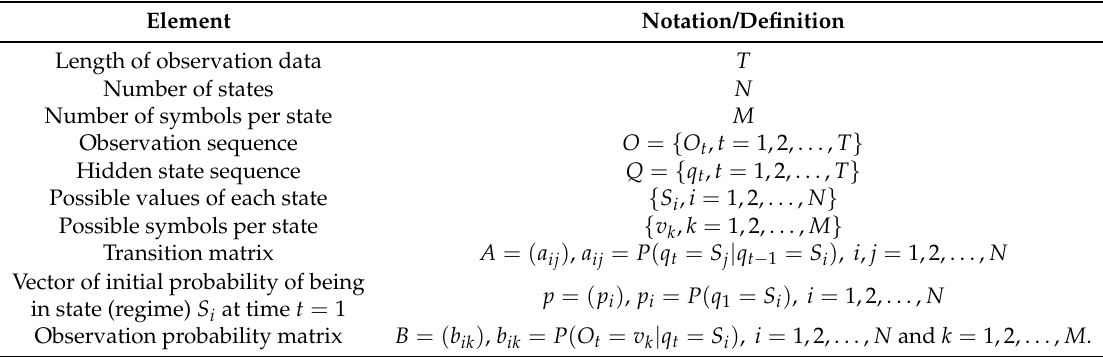
Table 1. The basic elements of a hidden Markov